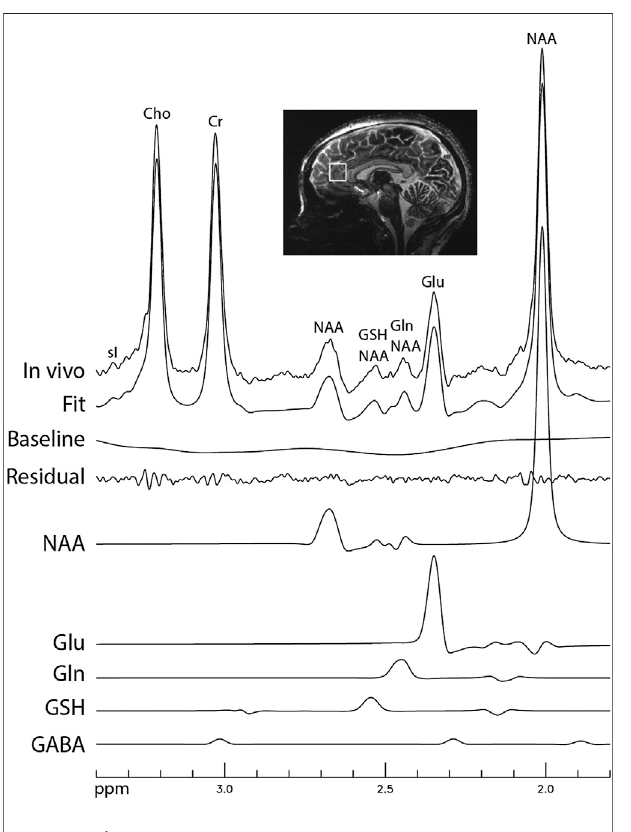
1000 repetitions. Compared to TE 1 = 69 ms, CV values for TE 1 = 16 ms were signi fi cantly reduced.